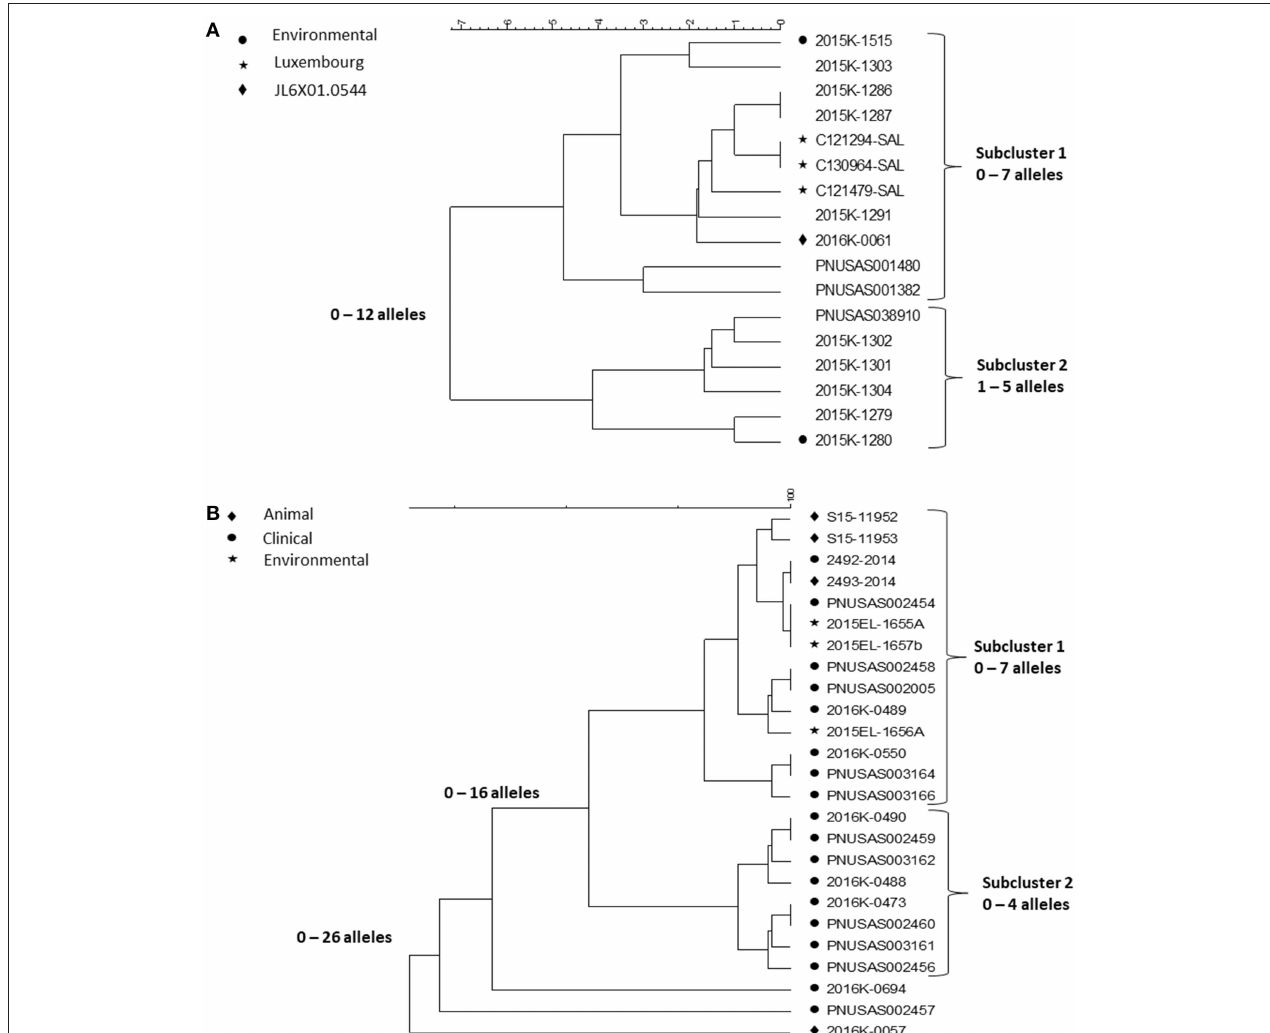
FIGURE 5 | cgMLST UPGMA trees of representative samples of sequences from one of the Salmonella outbreaks associated with turtle exposure. (A) shows the relationships between isolates of ser. Poona; isolates from the environment, from Luxemburg or of a PFGE pattern different from that displayed by all other isolates in the figure are indicated next to the strain identifier. (B) shows the relationship between isolates of ser. Pomona; the source of the isolates is indicated next to the strain identifier. Isolates 2493-2014 and 2492-2014 are from Chile. The range of allele differences are indicated at the branches of the tree and subclusters to the right of the